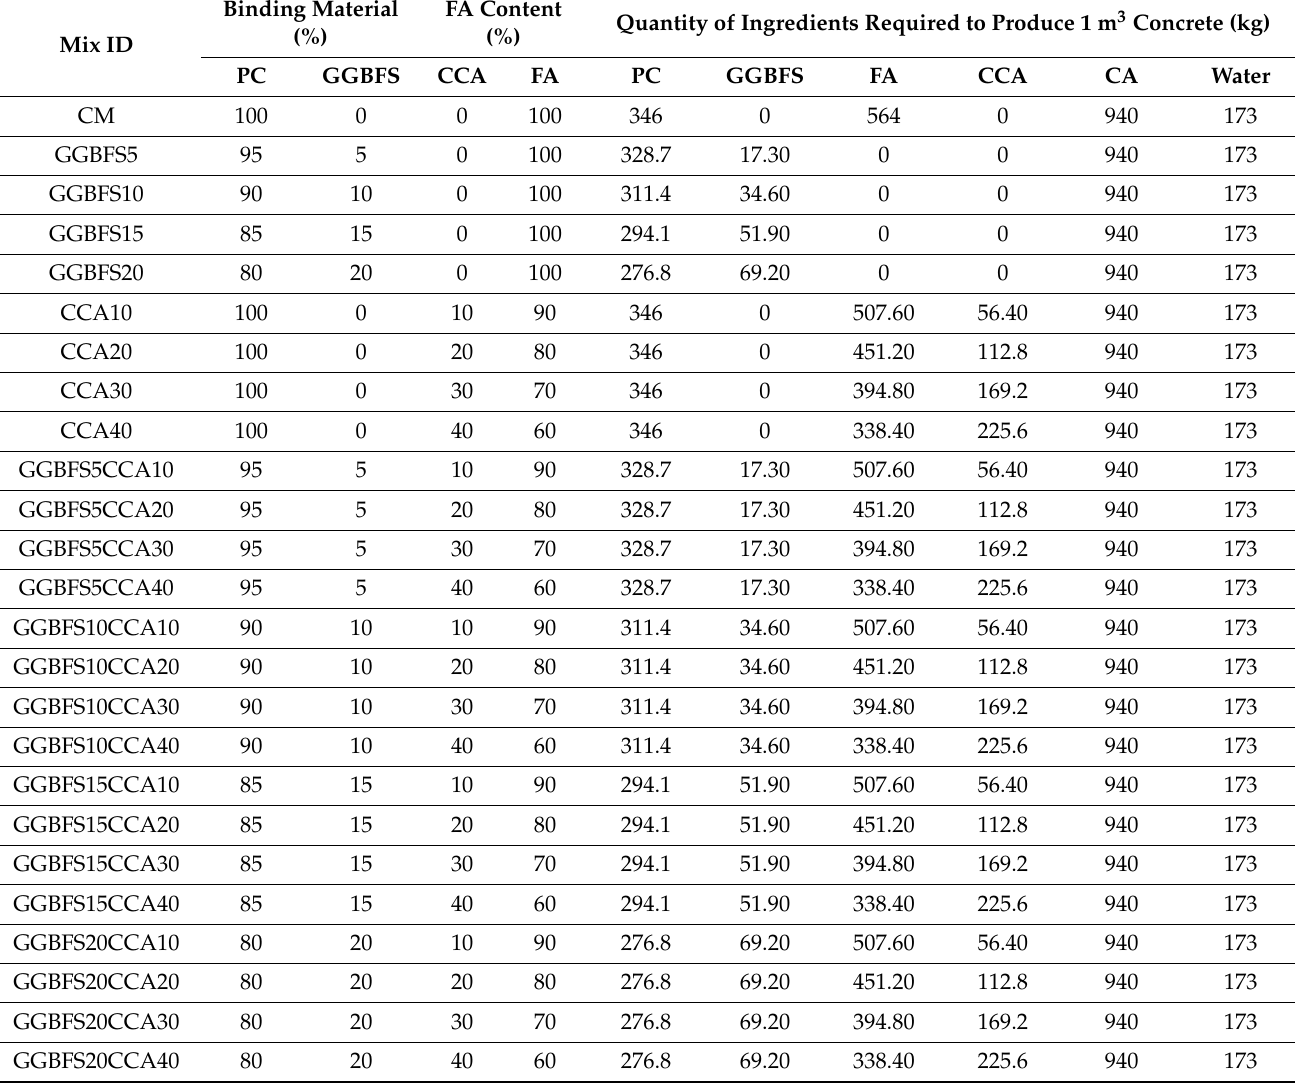
Table 3. Designs of the